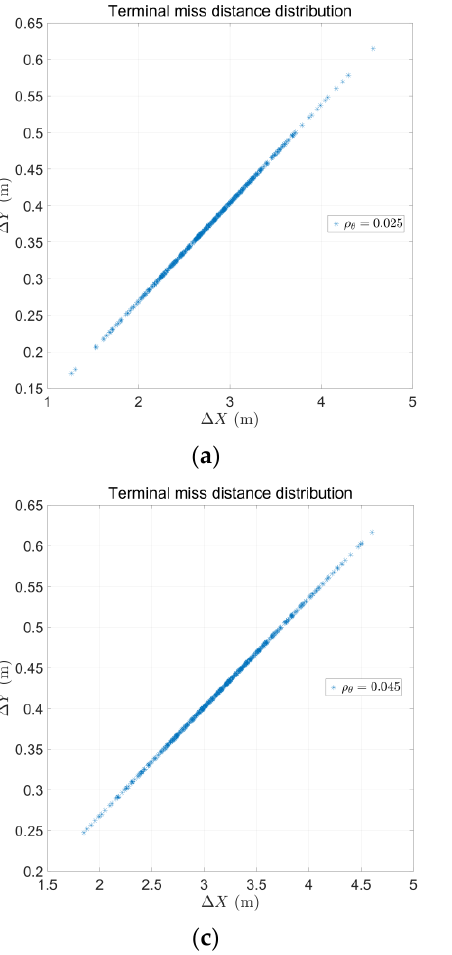
Figure 18. Terminal miss distance distribution for PNG with LOS angular rate correction. ( a )